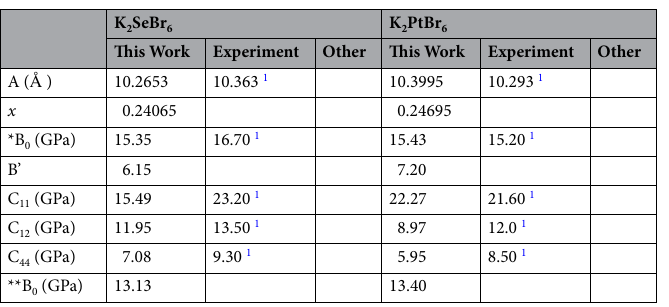
Table 1. The lattice constant, bulk modulus and its pressure derivative and elastic moduli of K 2 XBr 6 (X = Se, Pt).